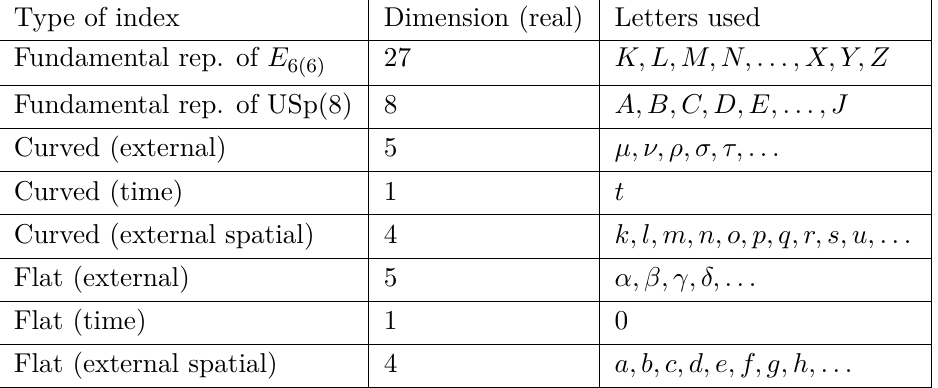
Table 3 . Conventions of the indices used, their dimensions and descriptions of the types of